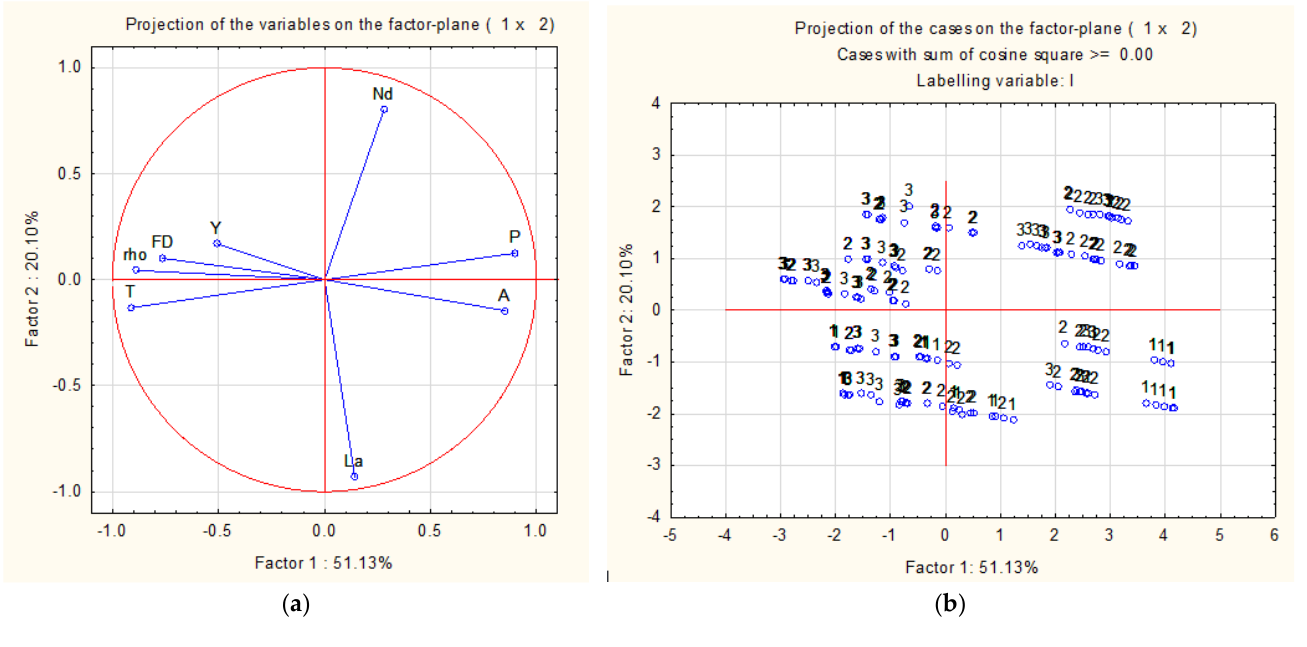
Figure 8. PCA including Fractal Dimension (FD) computed on images processed with the Find Edges tool; ( a ) variables plot, ( b ) Scores plot. Index I was used for grouping ceramics made from the A1–A3 alumina sources.